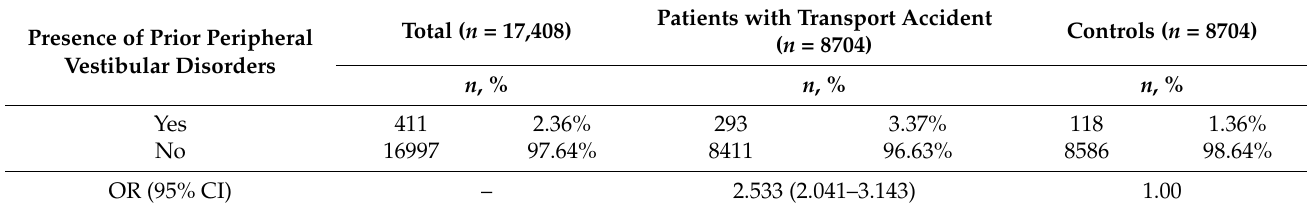
Table 2. Prevalence of vertigo and crude odds ratio of prior peripheral vestibular disorders among cases vs. controls. Total ( n = 17,408) Presence of Prior Peripheral Vestibular Disorders